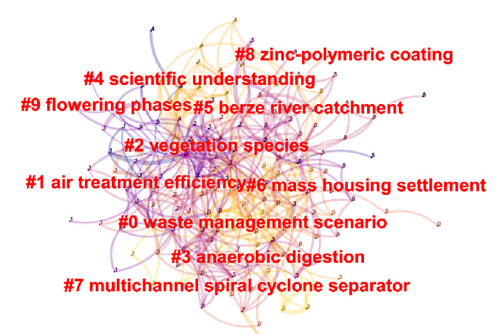
Figure 9. Cluster network of keyword research of JEELM